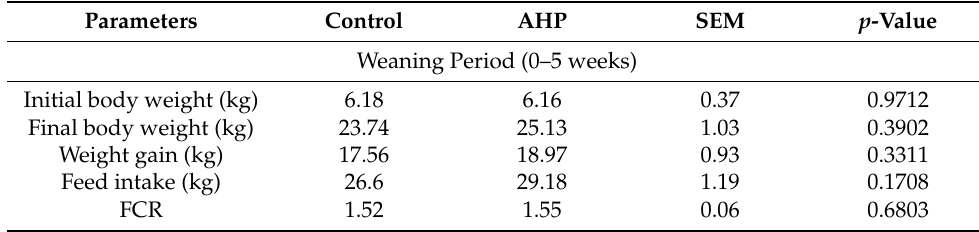
Table 1. Effect of the AHP cooling system on the growth performance parameters of pigs.